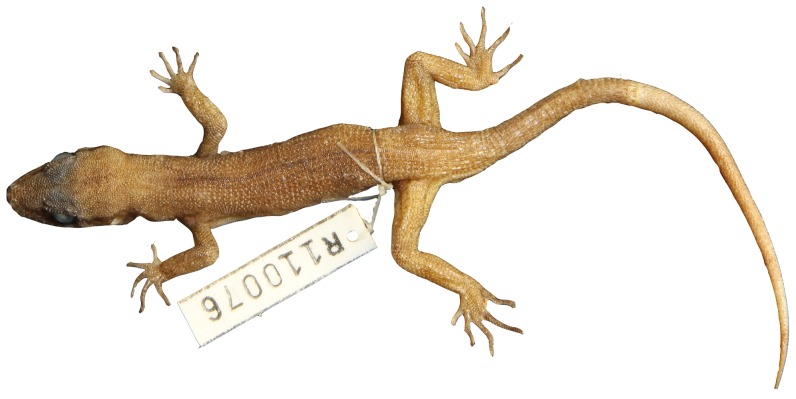

Heteronotia atra sp. nov. (holotype, WAM R110076).